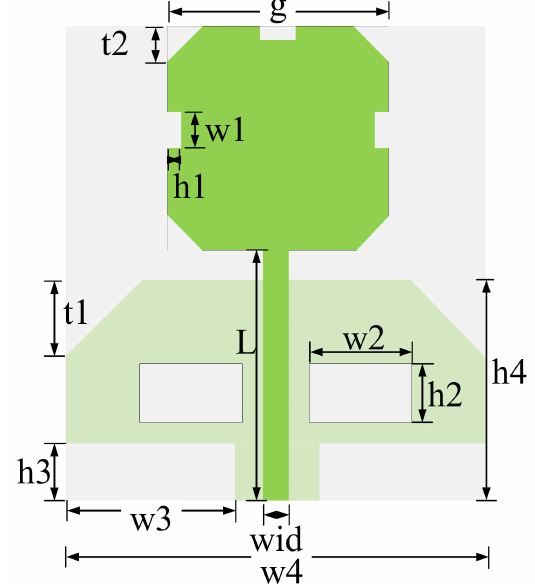
Figure 4. Broadband microstrip antenna unit model.